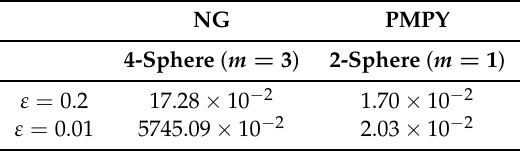
Table 2. Energy dissipation E ( γ ) of the most efficient NG and PMPY types of swimmers.